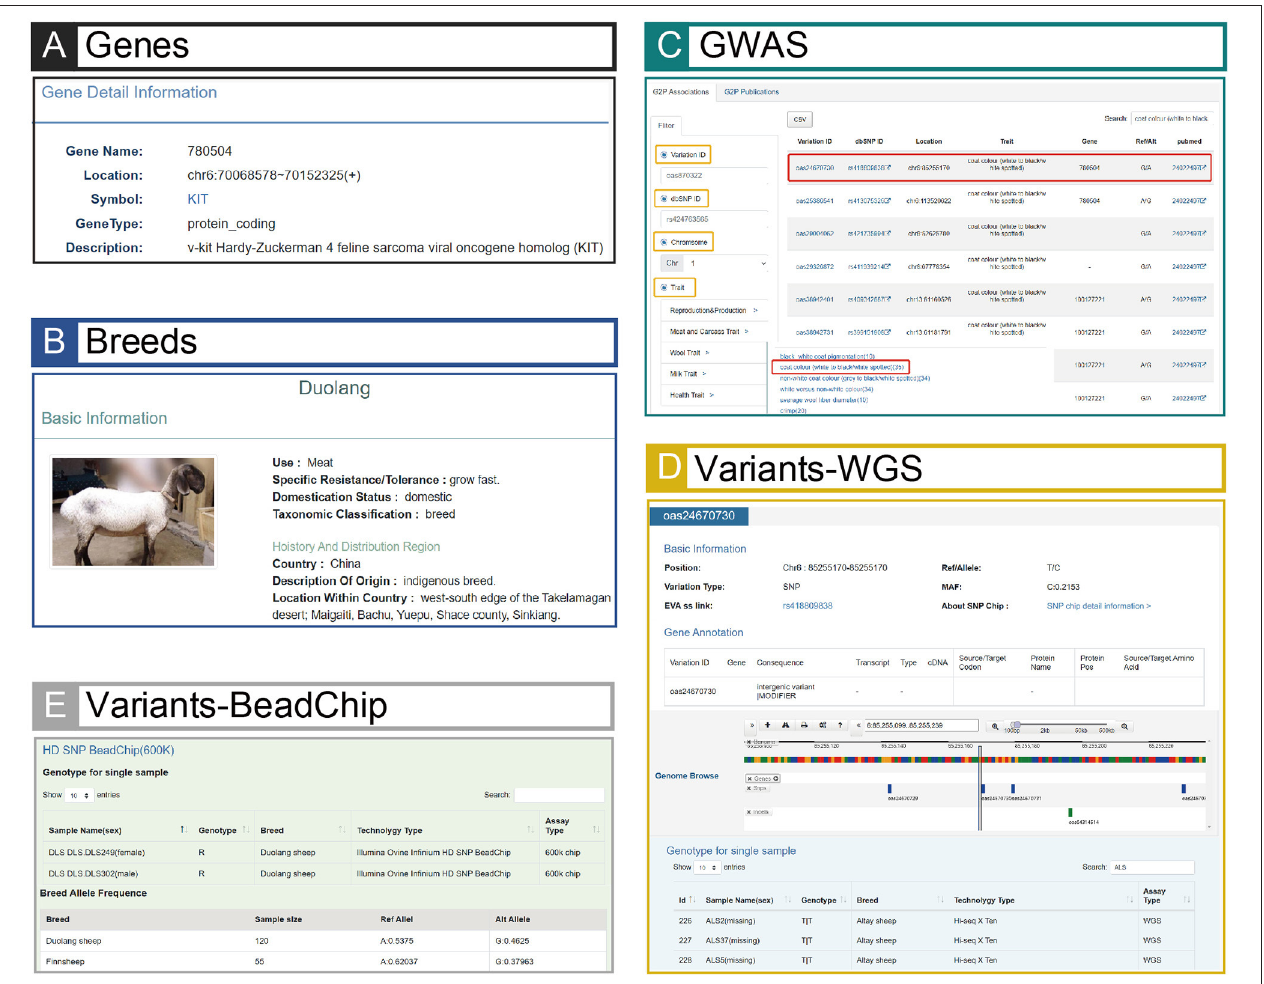
FIGURE 3 | Screenshots of GWAS, Variants, Breeds and Genes modules. (A) An example searching result of GWAS. The result page is linked to Genes (E) and Variants (B) , and the page can jump to corresponding pages when relevant buttons (e.g., variant ID: oas24670730, or gene name: 780504) are clicked. (B) An example result of Variants (variant ID: oas24670730). The result page shows detailed information of this example and links to extensional information of BeadChip data (C) . (C) An example result in BeadChip of Variants (variant ID: oas24670730). The result page is linked to (B) when the users click “SNP chip detail information > ”, and Duolang sheep with the highest mutation frequency in this example is shown in the table. (D) Phenotypic data of Duolang sheep. (E) Page of the gene (gene name: 780504) related to the variant (variant ID: oas24670730) in (A)